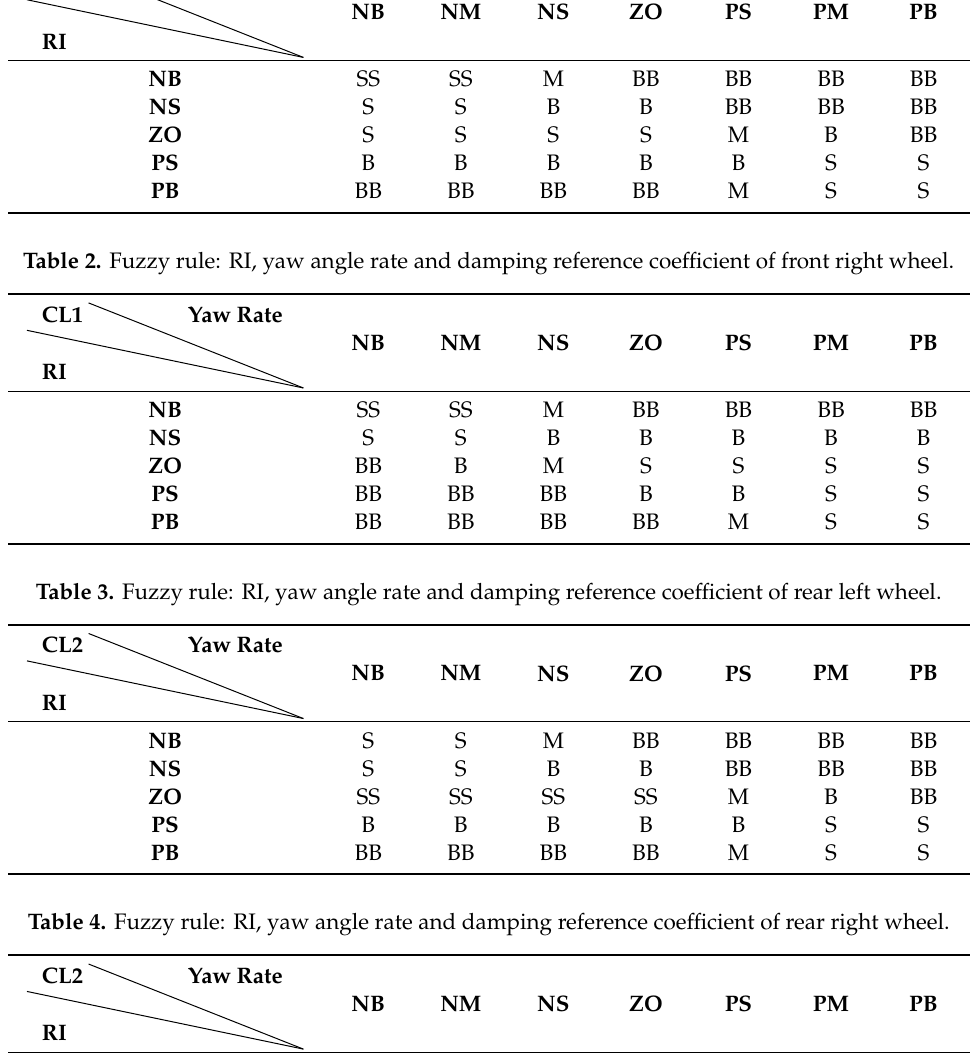
Table 1. Fuzzy rule: RI, yaw angle rate and damping reference coe ffi cient of front left wheel. RICL1